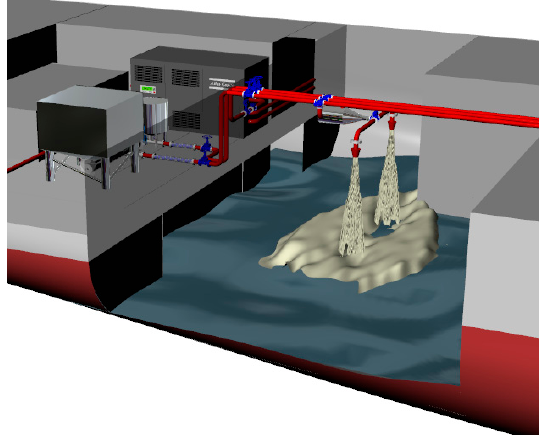
Figure 15. Filling void spaces on top of floodwater in a critical damaged compartment.